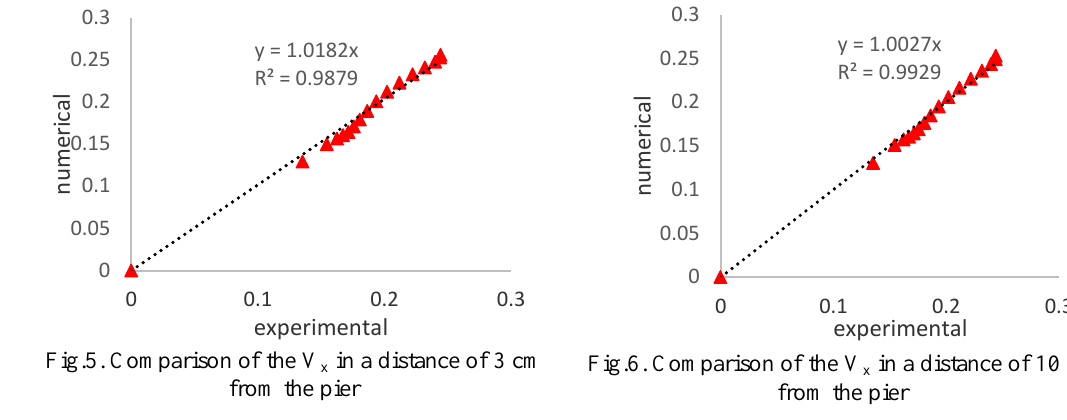
Fig.6. Comparison of the V